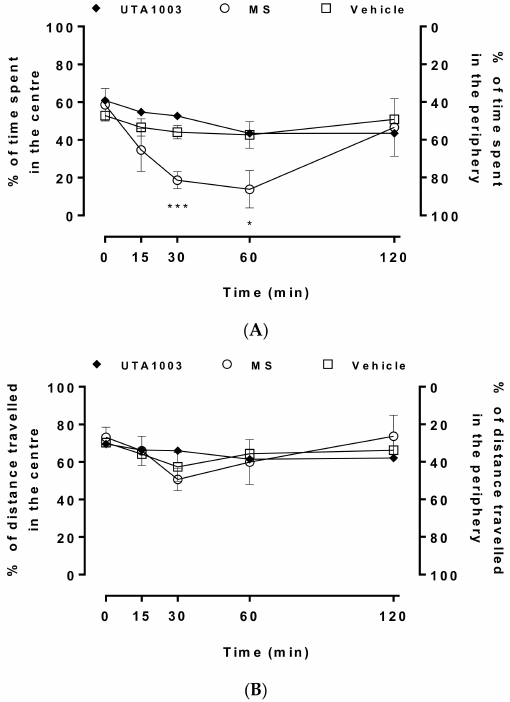
Figure 7. Place preferences after acute administration of opioids. Effects on time spent in the centre (% of total observation period, 5 min) or periphery ( A ) and distance travelled in the centre (% of total distance travelled by the animal) or periphery ( B ) of an open-field arena over a period of 120 min, after a single subcutaneous injection of vehicle or morphine (MS, 3.0 mg/kg) or UTA1003 (24.6 mg/kg) or UTA1003 (24.6 mg/kg) plus morphine (3.0 mg/kg), in Sprague Dawley rats. Statistically significant differences in a time point compared to vehicle in every group of animals are indicated (* p < 0.05, *** p < 0.001) and were calculated using one-way ANOVA with a Bonferroni’s multiple comparison test. Values are presented as mean ± SEM (n = 6 animals per